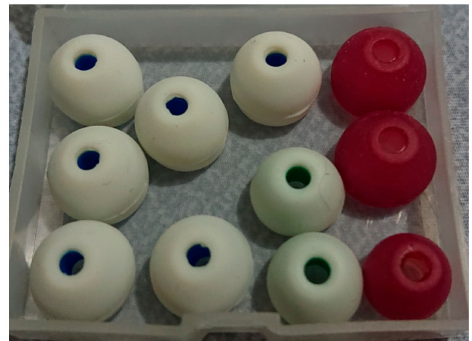
Figure 3. Di ff erent sizes of earphone